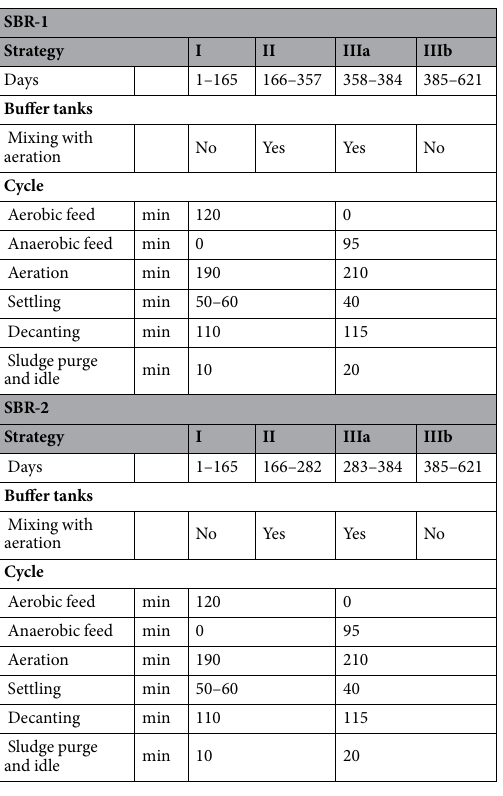
Table 1. Operational parameters applied to the full-scale SBRs (SBR1 and SBR2). Mitigation strategies consisted of the addition of polyaluminium chloride (I), inhibition of VFA production (II) and modification of the feeding pattern with (IIIa) or without (IIIb) aeration in the buffer tanks.